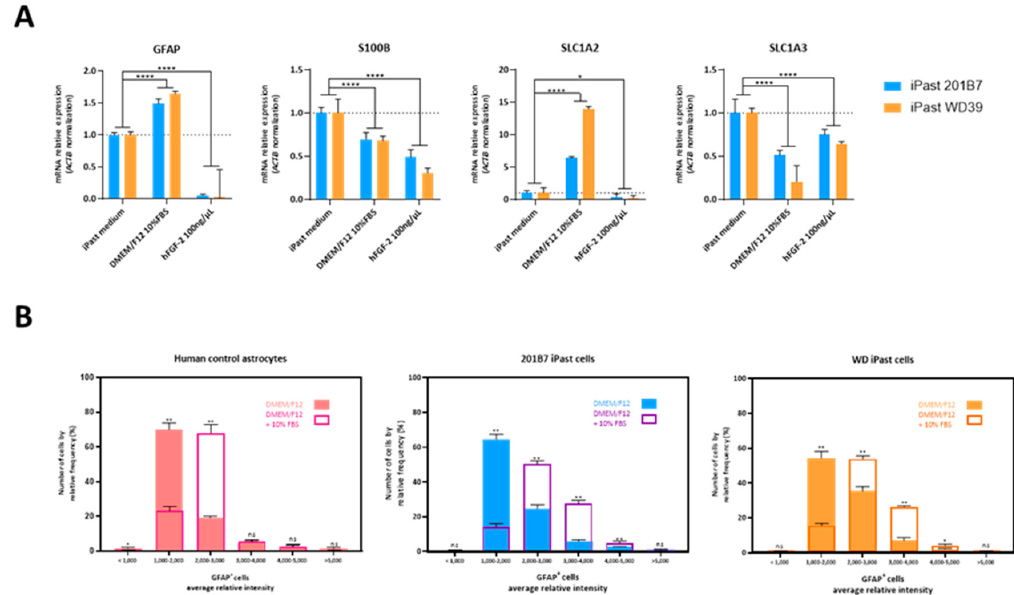
Figure 5. Effect of the Culture Medium on the Transcription of Various Genes in iPasts. ( A ) Cells were cultured in iPast medium, DMEM / F12 with 10% fetal bovine serum (FBS) or 100 ng / mL FGF-2. Quantification of indicated mRNAs was assessed by quantitative RT-PCR. Values were normalized to ACTB and represent the fold change ratio value (value / iPSC value). n = 3 passages. Statistical test: One-way ANOVA with post-hoc Tukey. **** and * indicate p -values (p) < 0.0001 ≤ 0.05, respectively. ( B ) Analysis of the distribution of GFAP + -iPasts depending on the individual mean GFAP intensity, using automatic immunofluorescence analysis by IN Cell Analyzer. Control human astrocytes, 201B7 and WD39 iPasts were cultured in iPast culture medium or DMEM / F12 plus 10% FBS. n = 3 passages. Statistical test used: Kolmogorov-Smirnov test. ** and * indicate p -values (p) < 0.01 and ≤ 0.05, respectively while ns stands for non